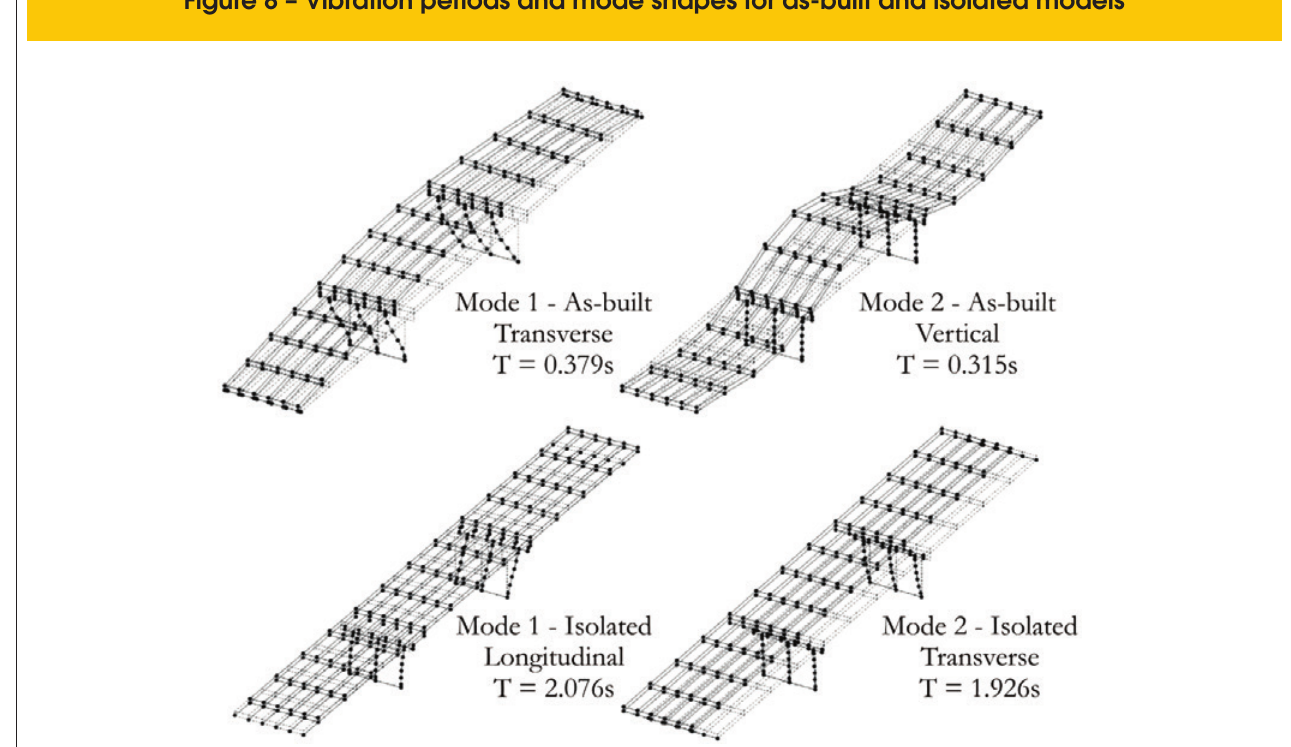
Figure 8 – Vibration periods and mode shapes for as-built and isolated